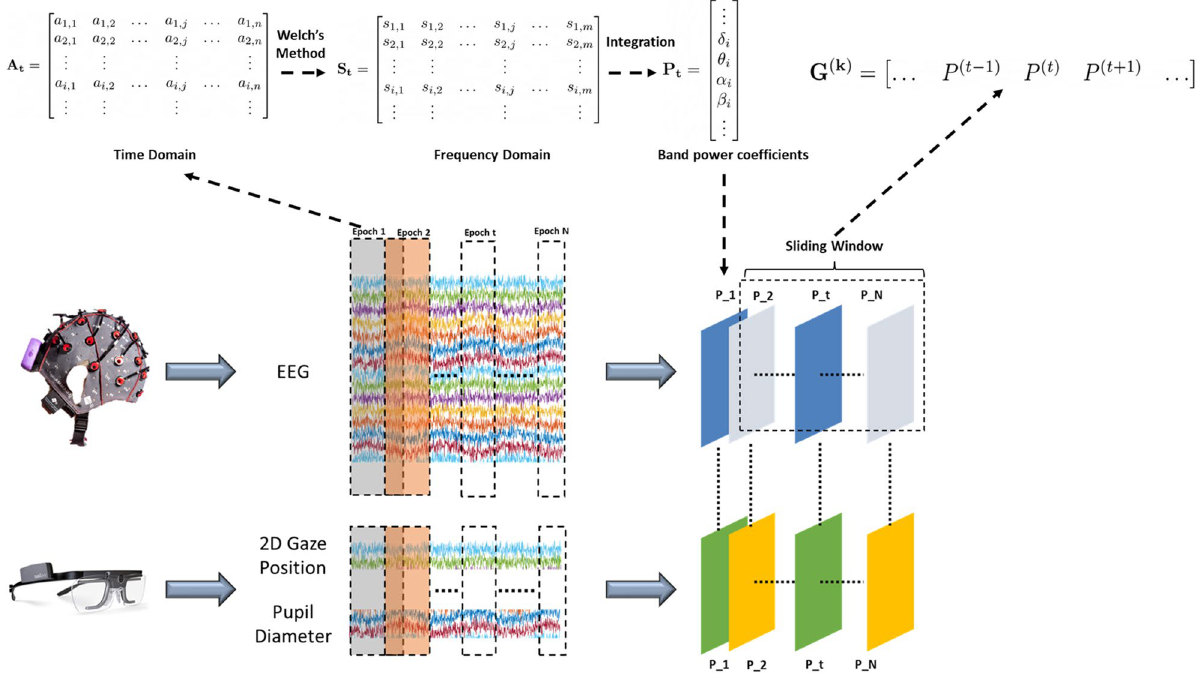
Figure 3. Diagram showing how the EEG and eye tracker signals are synchronized for the cognitive load detection